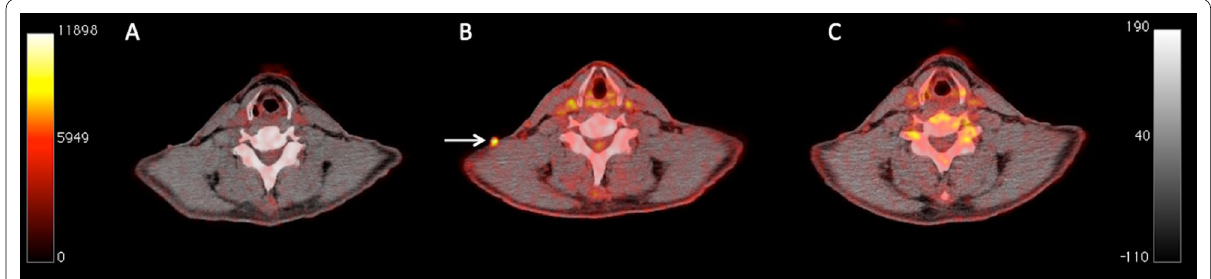
Fig. 1 Transaxial PET/CT images at the cervical level of a 55‑year‑old male melanoma patient undergoing immunotherapy with ipilimumab ( a – c ). The PET/CT images before immunotherapy showed no pathologic lesions ( a ). Interim PET/CT performed after two cycles of ipilimumab demonstrated a new, small, 18 F‑FDG‑avid subcutaneous lesion in the patient’s neck (white arrow; b ), suspicious of metastatic involvement (uPMD, according to EORTC). A third PET/CT obtained soon after administration of four cycles of ipilimumab showed remission of the lesion ( c ), suggesting pseudoprogression of the cervical finding on interim PET/CT. The application of PERCIMT classified the patient as SMD already at the time of interim PET/CT, thus avoiding misinterpretation. At last follow‑up the patient was still alive having reached an OS of 84.4 months